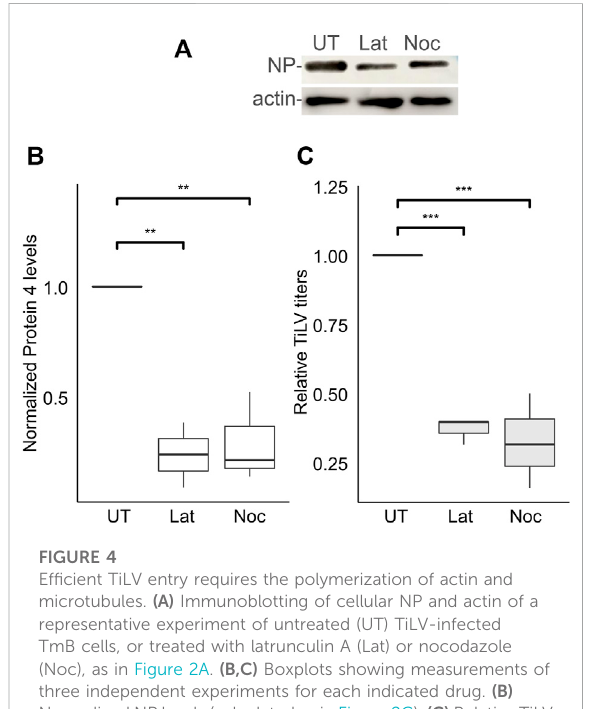
FIGURE 5 Leptomycin B strongly inhibits TiLV ’ s infectious virion production. (A) Immunoblotting of cellular NP and actin of a representative experiment of untreated (UT) TiLV-infected TmB cells, or treated with Leptomycin B (LMB). Infected cultures were incubated with the drug for an additional 24 h after the entry window. (B,C) Boxplots showing measurements of three independent experiments, as in (A) . (B) Normalized NP levels (calculated as in Figure 2C). (C) Relative TiLV titers (calculated as in Figure 2D). **, p ≤